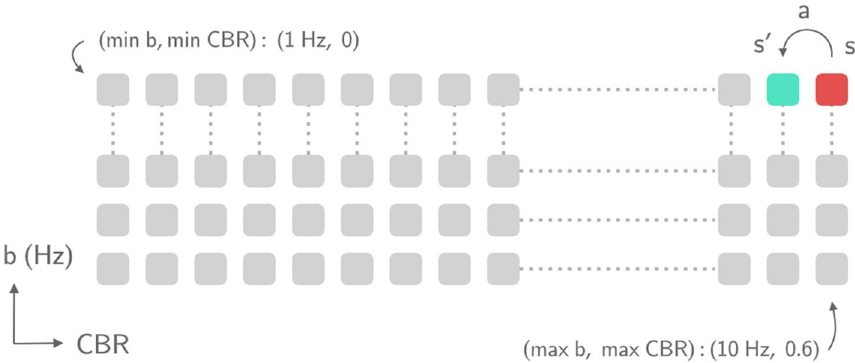
Figure 1. Two-dimensional space of states employed to model the beaconing rate allocation problem as an MDP. Axes represent each constituent element of the available states of the MDP: beaconing rate and